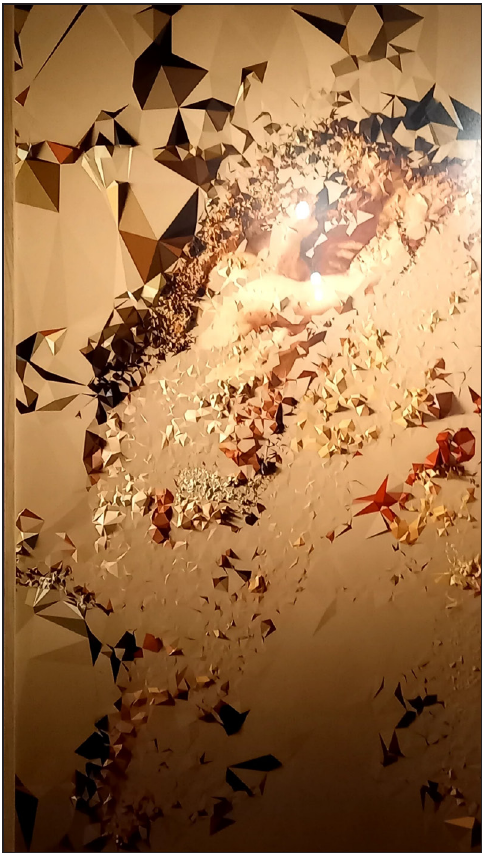
Figure 2: Davide Quayola. Iconographies #16: Venus and Adonis after Rubens, 2016. Photo Susan Broadhurst, 29 th September, 2021.